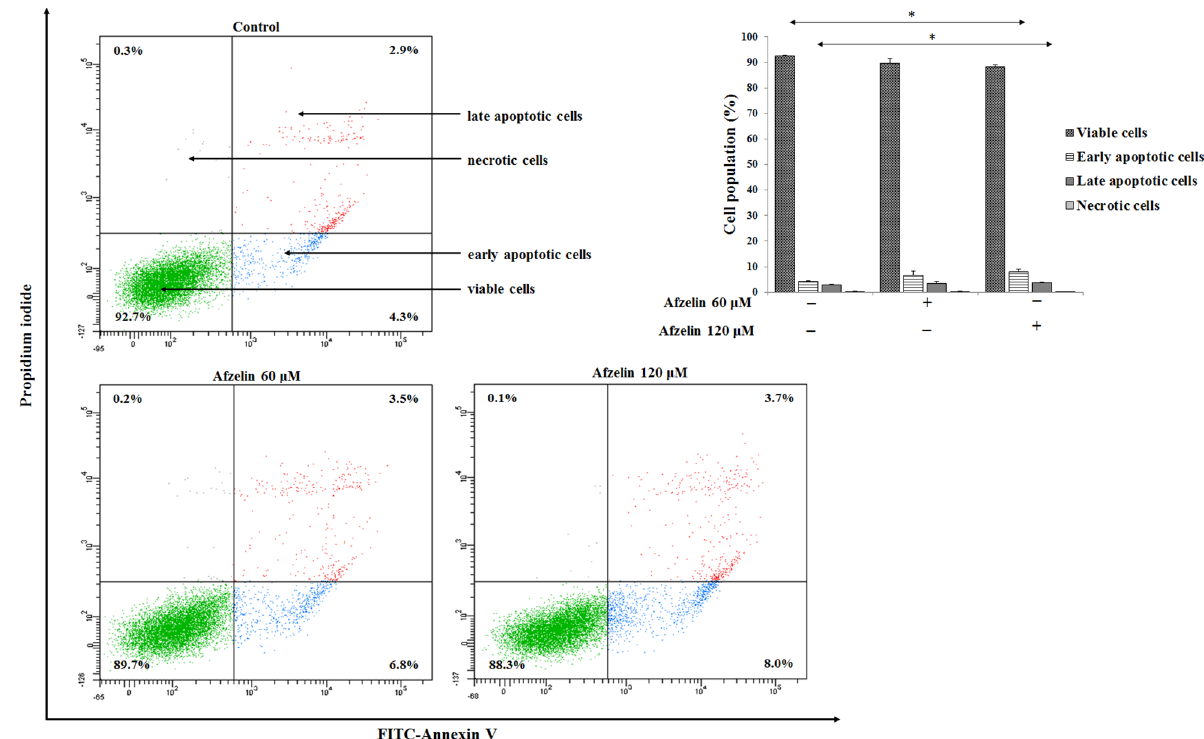
Figure 3. Flow cytometry determination of AGS cancer cells after 24 h incubation with 60 μ M and 120 μ M afzelin and subsequent staining with Annexin V and propidium iodide. The data are presented as mean percentages from 3 independent experiments done in duplicate. * p < 0.05, compared to the untreated control.